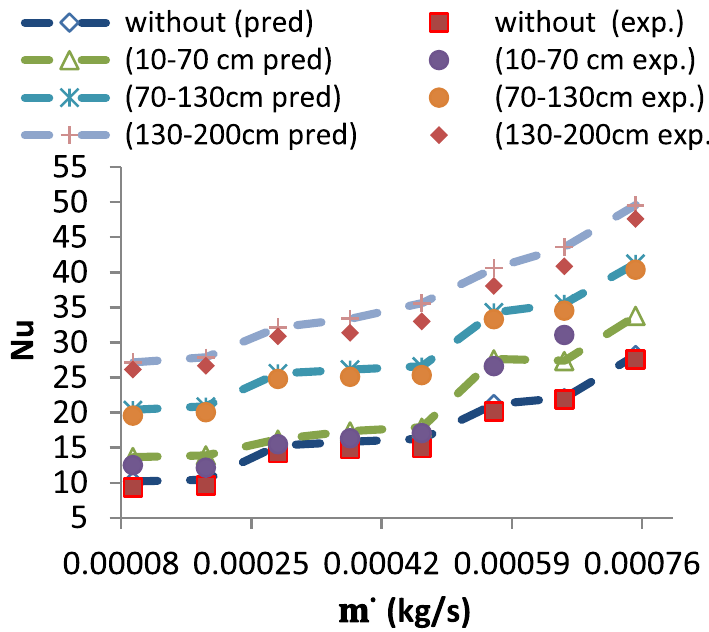
Fig. 11 ANN predicted and experimental Nusselt number with and without